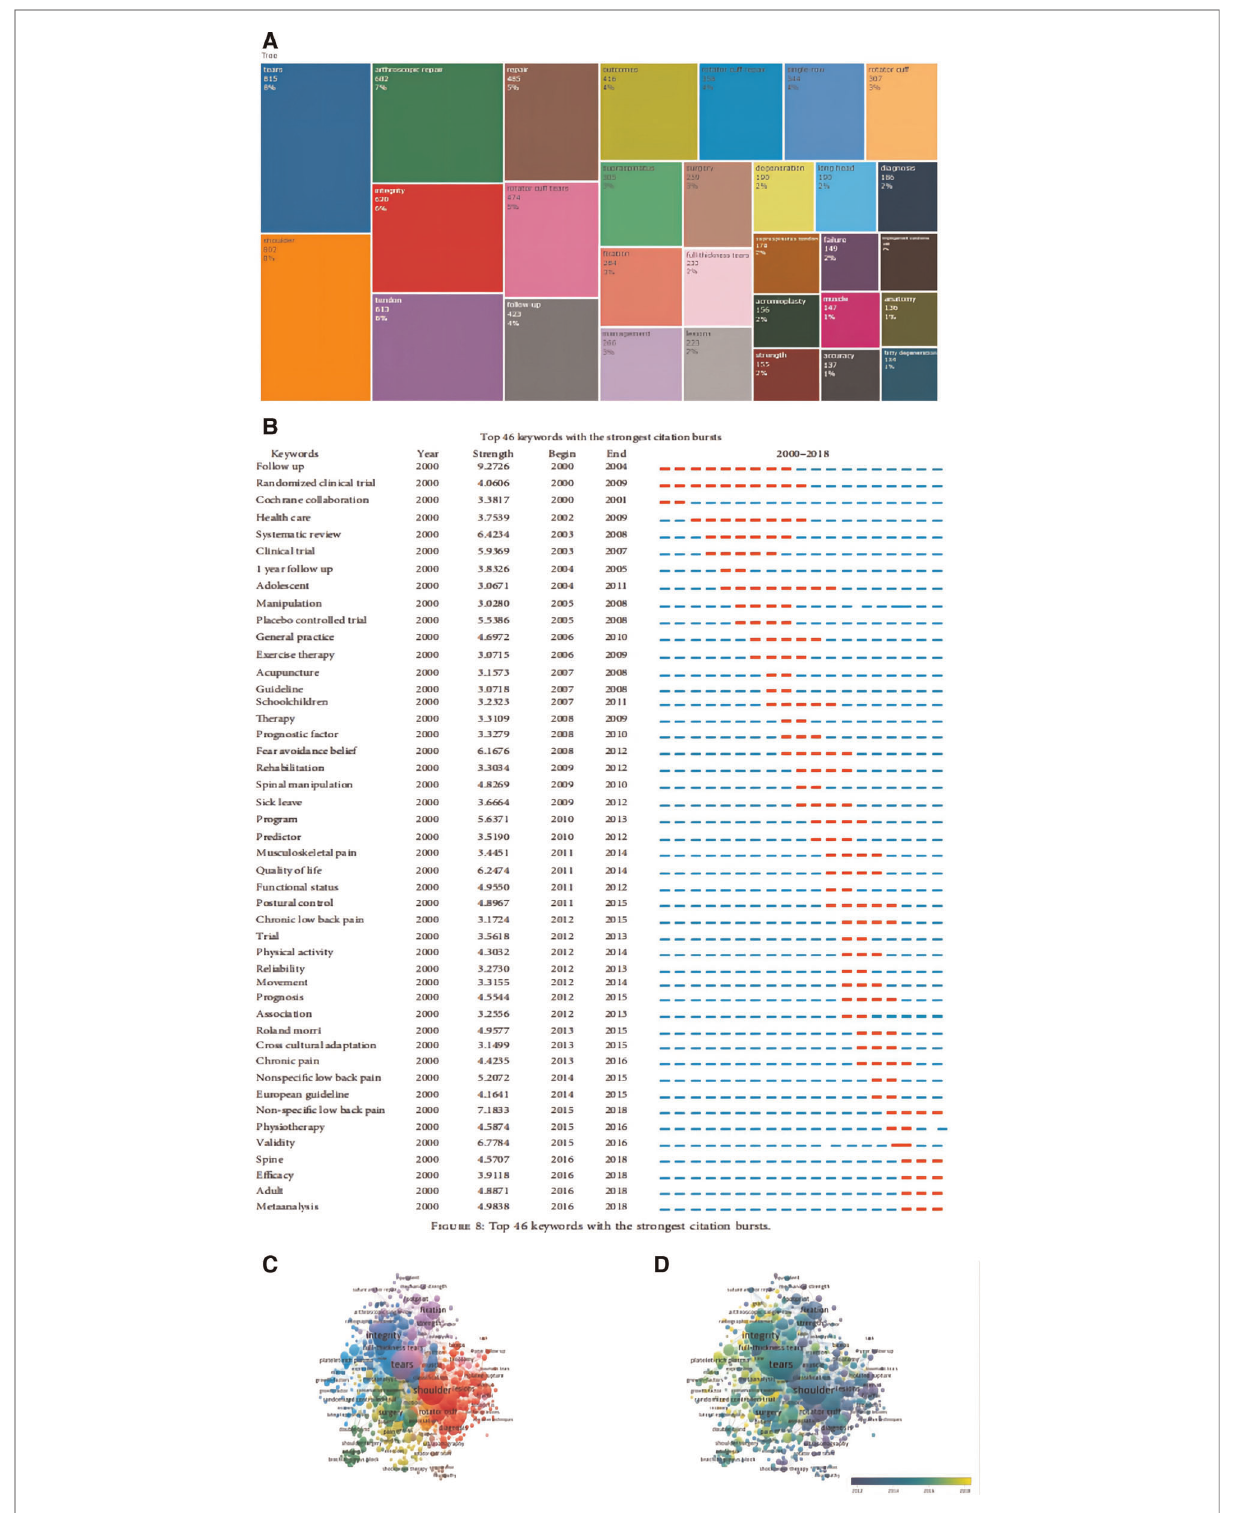
FIGURE 6 Keywords analysis of arthroscopic therapy of rotator cuff diseases related publications from 2002 to 2021. ( A ) Map of the top 30 most frequent keywords. ( B ) The dynamic growth of the top 50 most frequent keywords (Analysis based on the annual frequency). ( C ) The cluster map of